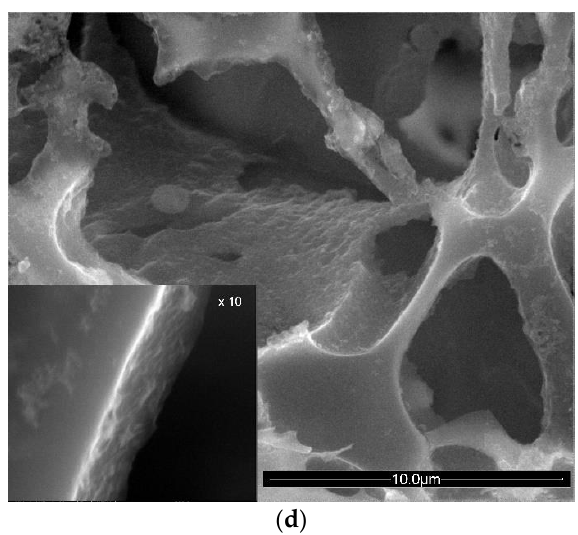
Figure 2. SEM images of ( a ) DPC, ( b ) ADPC0.5, ( c ) ADPC1, and ( d ) ADPC3. The insets in (a), (b), (c), and (d) show further magnified images.